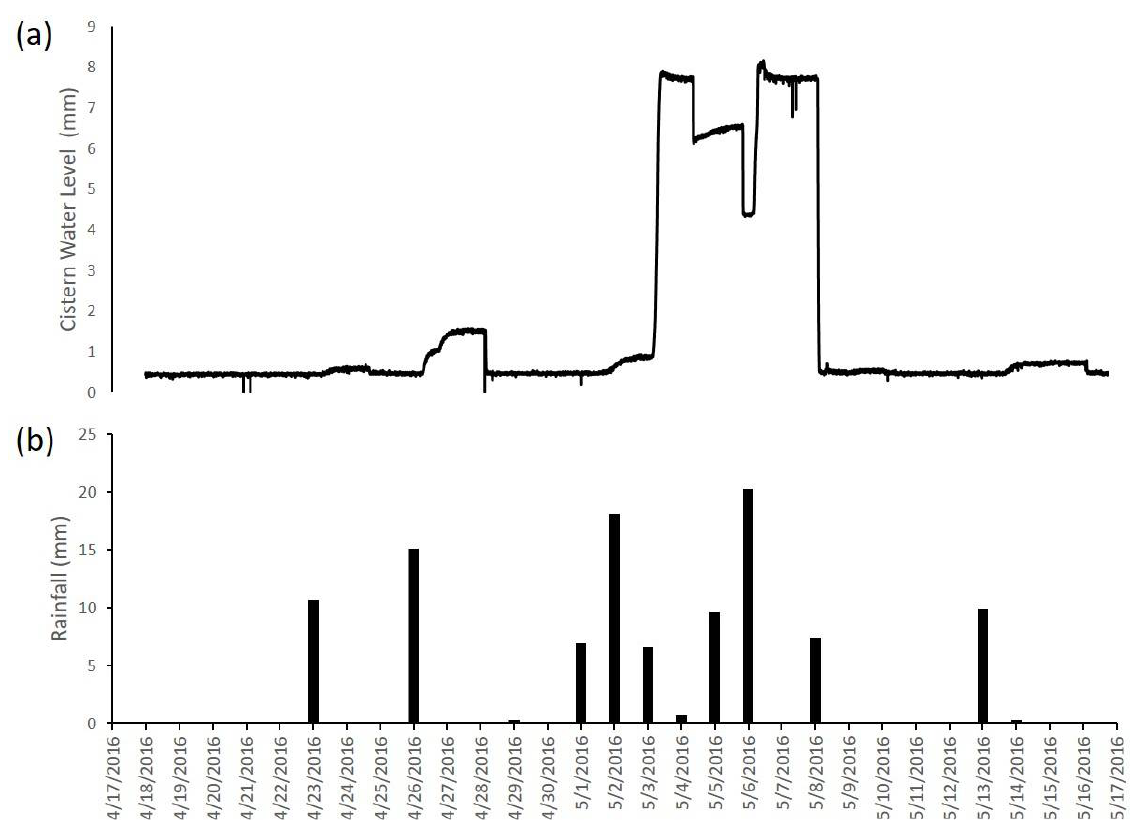
Figure 4. Time series of normalized cistern water level ( a ) and daily rainfall amount ( b ) for a one-month period, from 17 April 2016 to 17 May 2016.